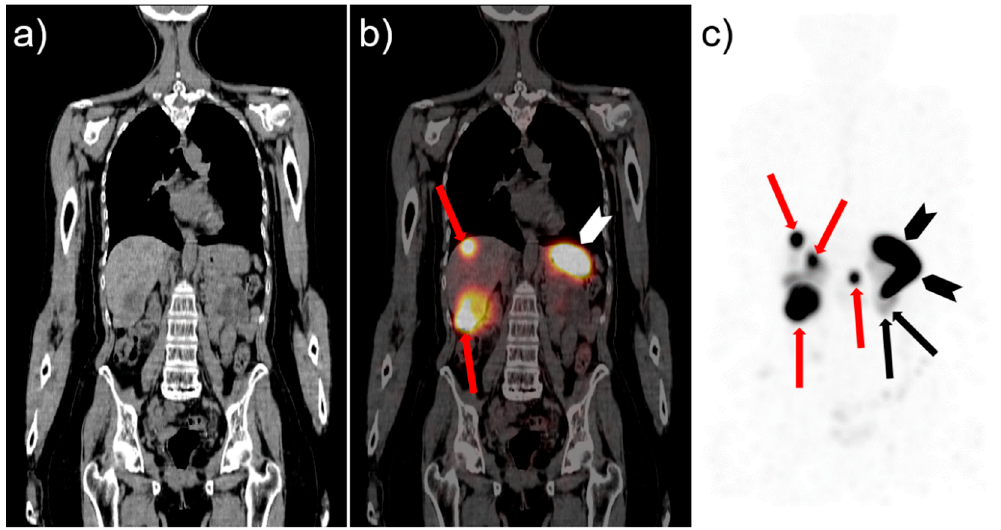
Figure 4. CT ( a ) and fused [ 177 Lu]Lu-PP-F11N SPECT/CT ( b ) images in coronal orientation. Corresponding maximum intensity projection image of SPECT data ( c ). Images 72 h after infusion of 6.3 GBq (<100 µg peptide) in a female patient with hepatic MTC metastases demonstrates strong uptake of the radiopharmaceutical in hepatic metastases and stomach. Red arrows: Liver metastases; white and black arrowheads: stomach; black arrows: Kidney; courtesy of Dr. Christof